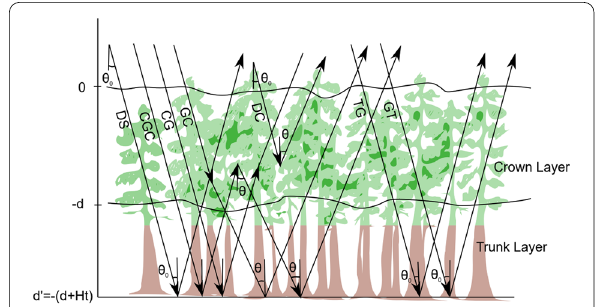
Fig. 4 Scattering mechanisms in the first-order Bi-mimics model, including the GCG, CG, DC, GC, GT, DG, and TG terms. The SG term is not shown. The crown layer depth is Z1 Z2